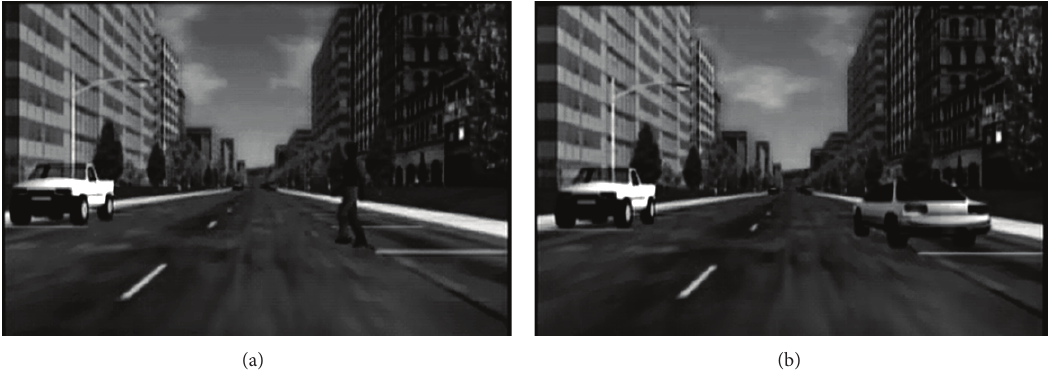
Figure 1: Examples of potential hazards in the hazard driving task. In (a), a pedestrian crosses the street in front of the driver. In (b), a parked vehicle starts to pull out in front of the driver.